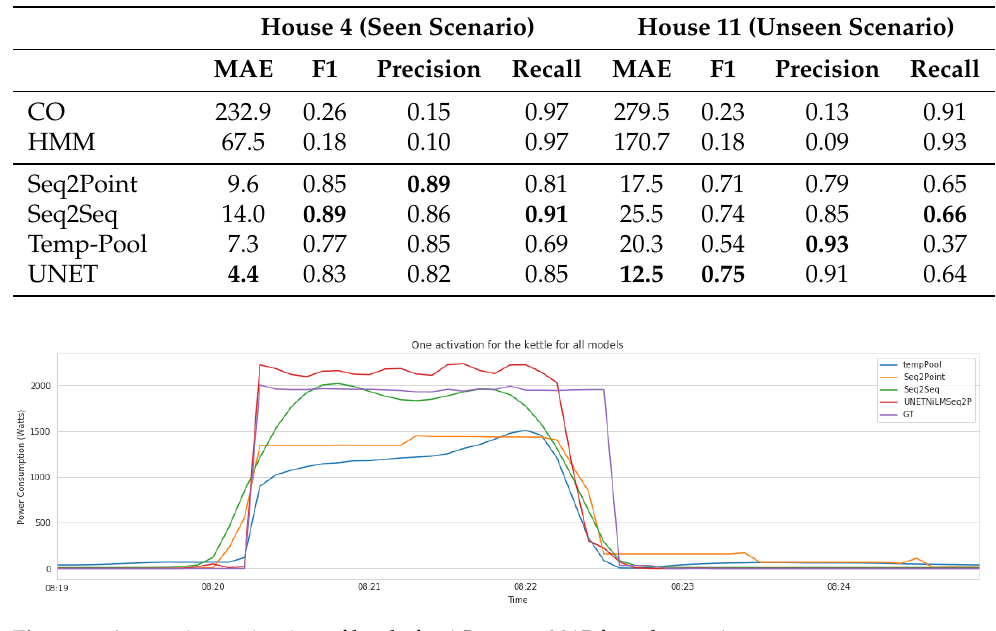
Figure 7. A morning activation of kettle for 1 January 2015 from house